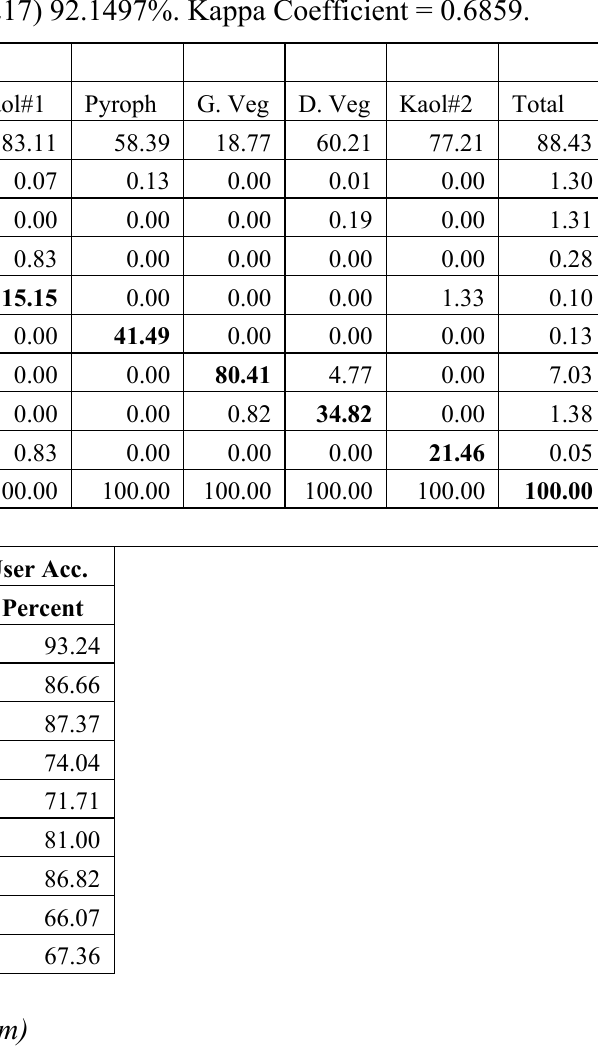
Table 2. Confusion matrix for Steamboat Springs, Nevada, 15 m versus 60 m